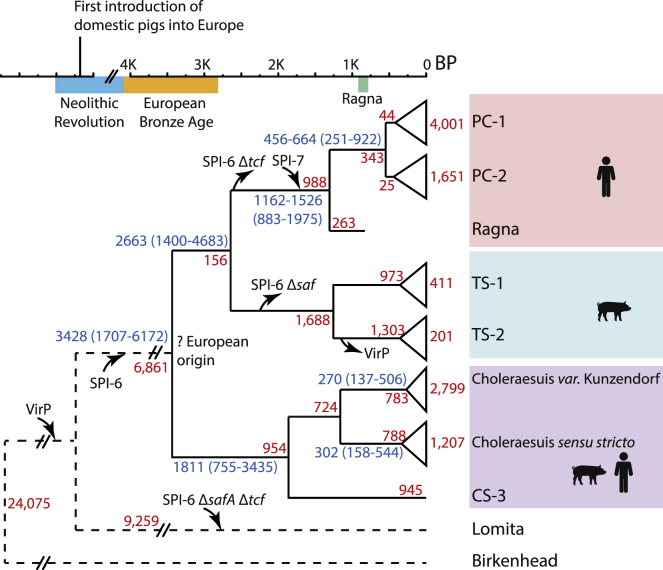
Cartoon of the Evolutionary History of the Para C Lineage on a Time Frame for Human History in EuropeBP: before present. The tree is annotated with the acquisitions of the virulence plasmid (VirP), SPI-6 and SPI-7 as annotated by inward arrows, and deletions of parts of SPI-6 as annotated by outward arrows. Numbers in blue indicate date estimates and their 95% credible intervals (parentheses) according to a Bayesian phylogenetic approach. Red numbers indicate numbers of substitution events for non-recombinant core SNPs except for Lomita and Birkenhead, where they indicate total core SNPs. The host specificities of the individual serovars are indicated by cartoons at the right.See also Figure S3 for the timing of individual changes in pseudogenes and gene gain/loss, Figure S4 for the locations of variable genes by lineage within SPI-6, Table S3 for the properties of individual genomic islands, and Table S4 for detailed estimates of tMRCAs. See also Table S2.